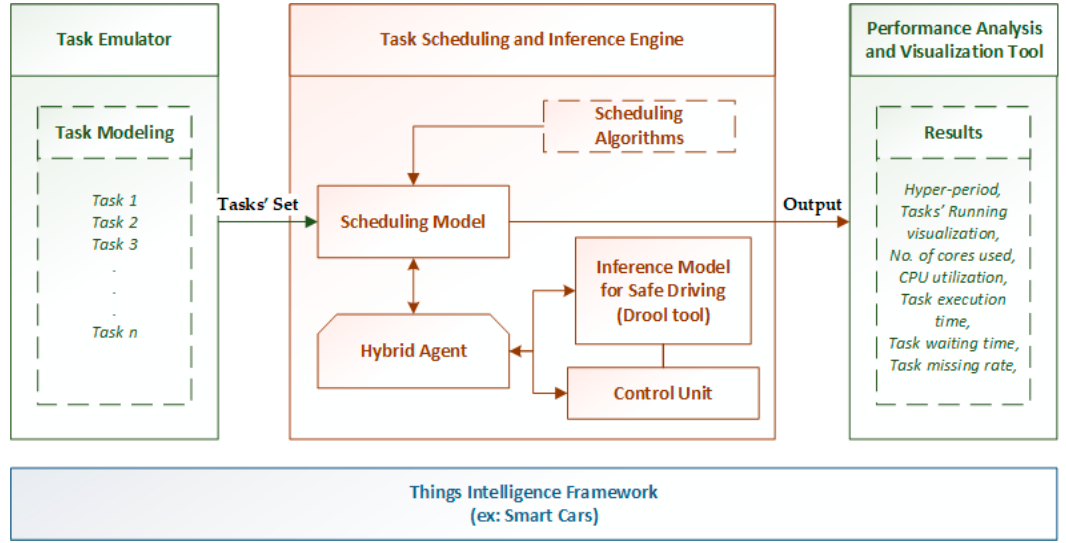
Figure 2. Intelligence framework model for hybrid task scheduler and inference engine.